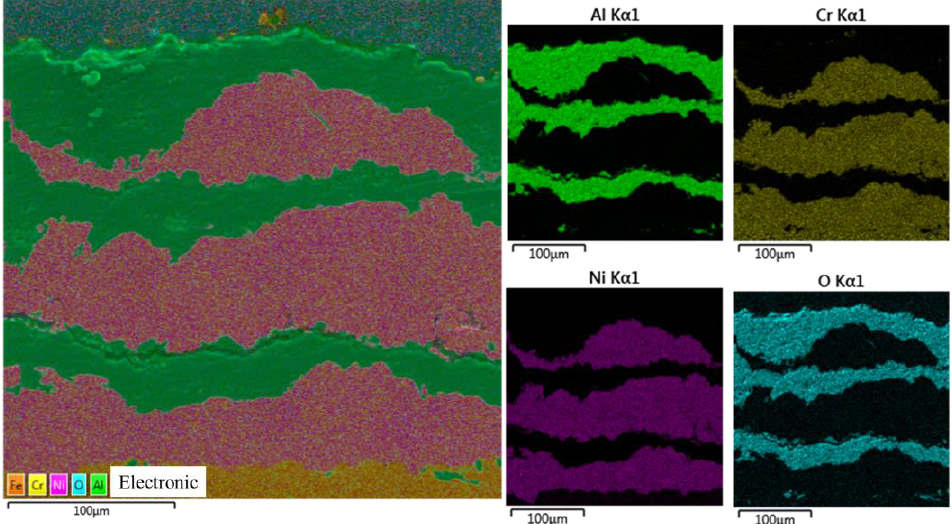
Figure 10. SEM images of the cross-section morphology of the six-layer gradient coating.